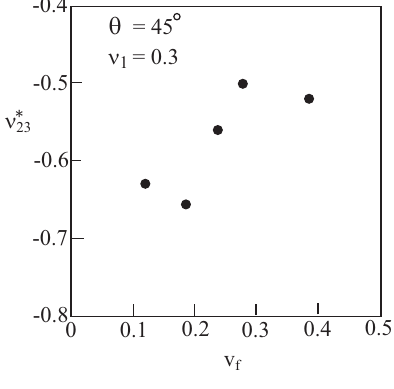
Figure 4. Variation of the effective Poisson’s ratio ν ∗ with voids ( θ = 45 ◦